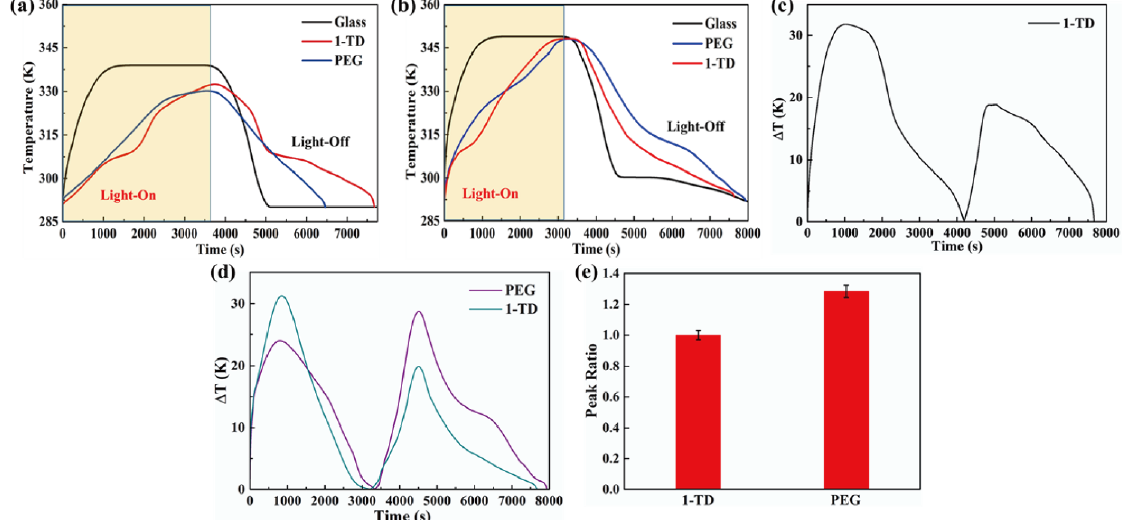
Figure 8. Temperature profiles of glass, 1-TD, and PEG under solar light ( a ) intensity of 10 mW/cm 2 and ( b ) intensity of 15 mW/cm 2 . ( c ) Temperature difference of the 1-TD composite under 10 mW/cm 2 , ( d ) temperature difference of both the PEG and 1-TD composite under 15 mW/cm 2 , and ( e ) peak area ratios of the PCM composites under 15 mW/cm 2 .